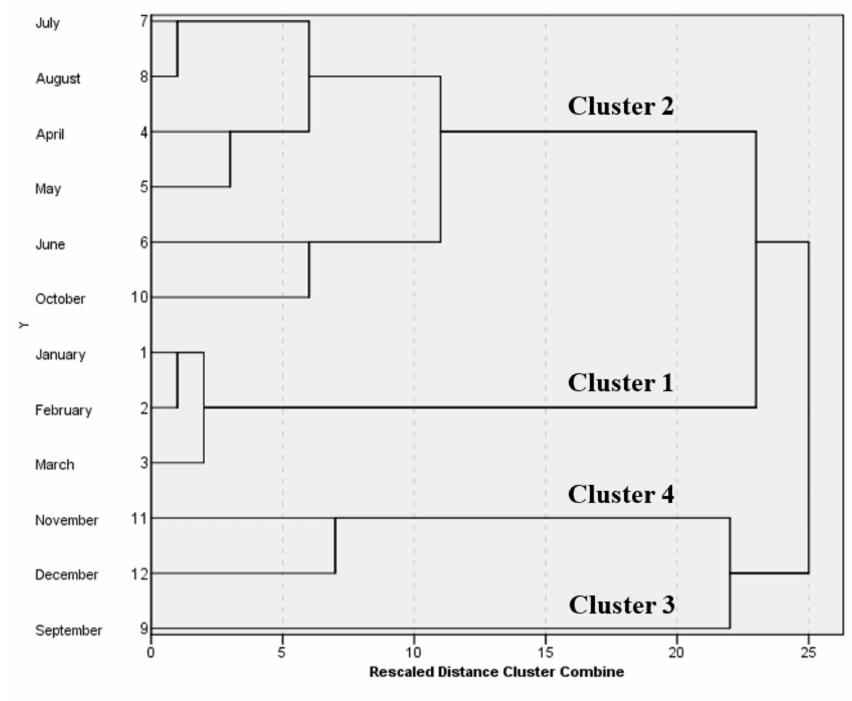
Figure 4. Dendrogram using Ward’s linkage for seasonal